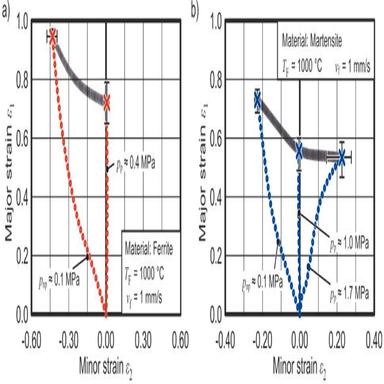
Forming limit diagrams from the pressurized-tube-tensile test as well as the corresponding strain paths at TF = 1000 ◦C with self-defined limits for a) ferriticand b) martensitic stainless steel tubes.